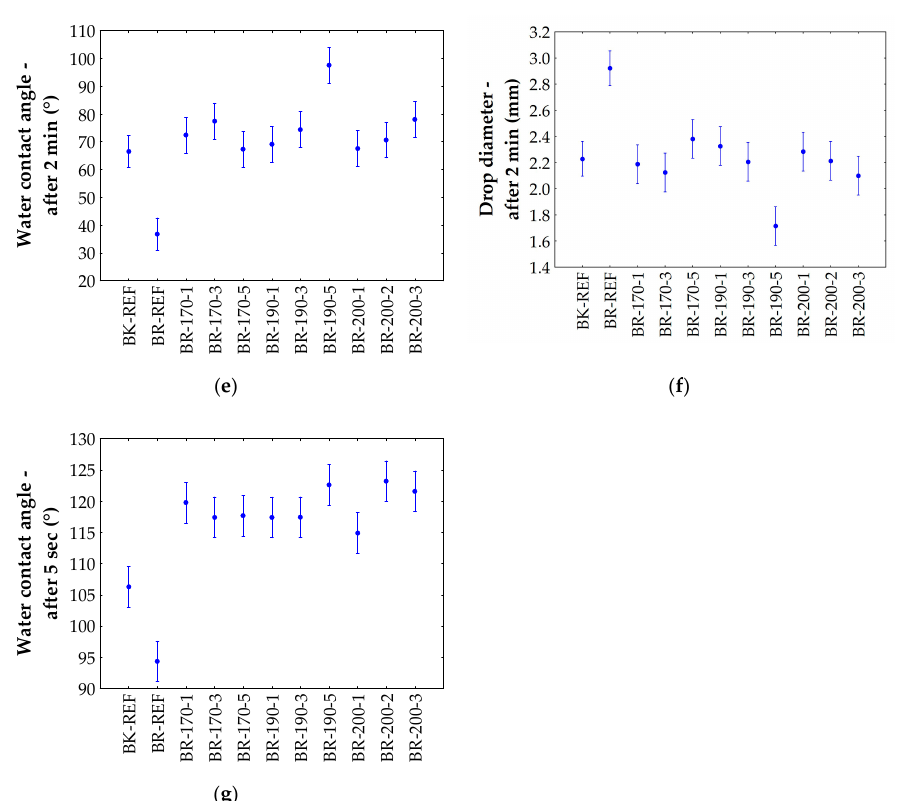
Figure 10. The graphic visualization of the e ff ect of heat-treatment temperature and heat-treatment time limit (peak stage) on wetting parameters ( a ) water contact angle—immediate, ( b ) drop diameter—immediate, ( c ) water contact angle—after 1 min, ( d ) drop diameter—after 1 min, ( e ) water contact angle—after 2 min, ( f ) drop diameter—after 2 min and ( g ) water contact angle—after 5 s. BK-REF = untreated beech; BR-REF = untreated birch; BR-170-1 = birch treated at 170 ◦ C / 1 h; BR-170-3 = birch treated at 170 ◦ C / 3 h; BR-170-5 = birch treated at 170 ◦ C / 5 h; BR-190-1 = birch treated at 190 ◦ C / 1 h; BR-190-3 = birch treated at 190 ◦ C / 3 h; BR-190-5 = birch treated at 190 ◦ C / 5 h; BR-200-1 = birch treated at 200 ◦ C / 1 h; BR-200-2 = birch treated at 200 ◦ C / 2 h; BR-200-3 = birch treated at 200 ◦ C / 3 h.